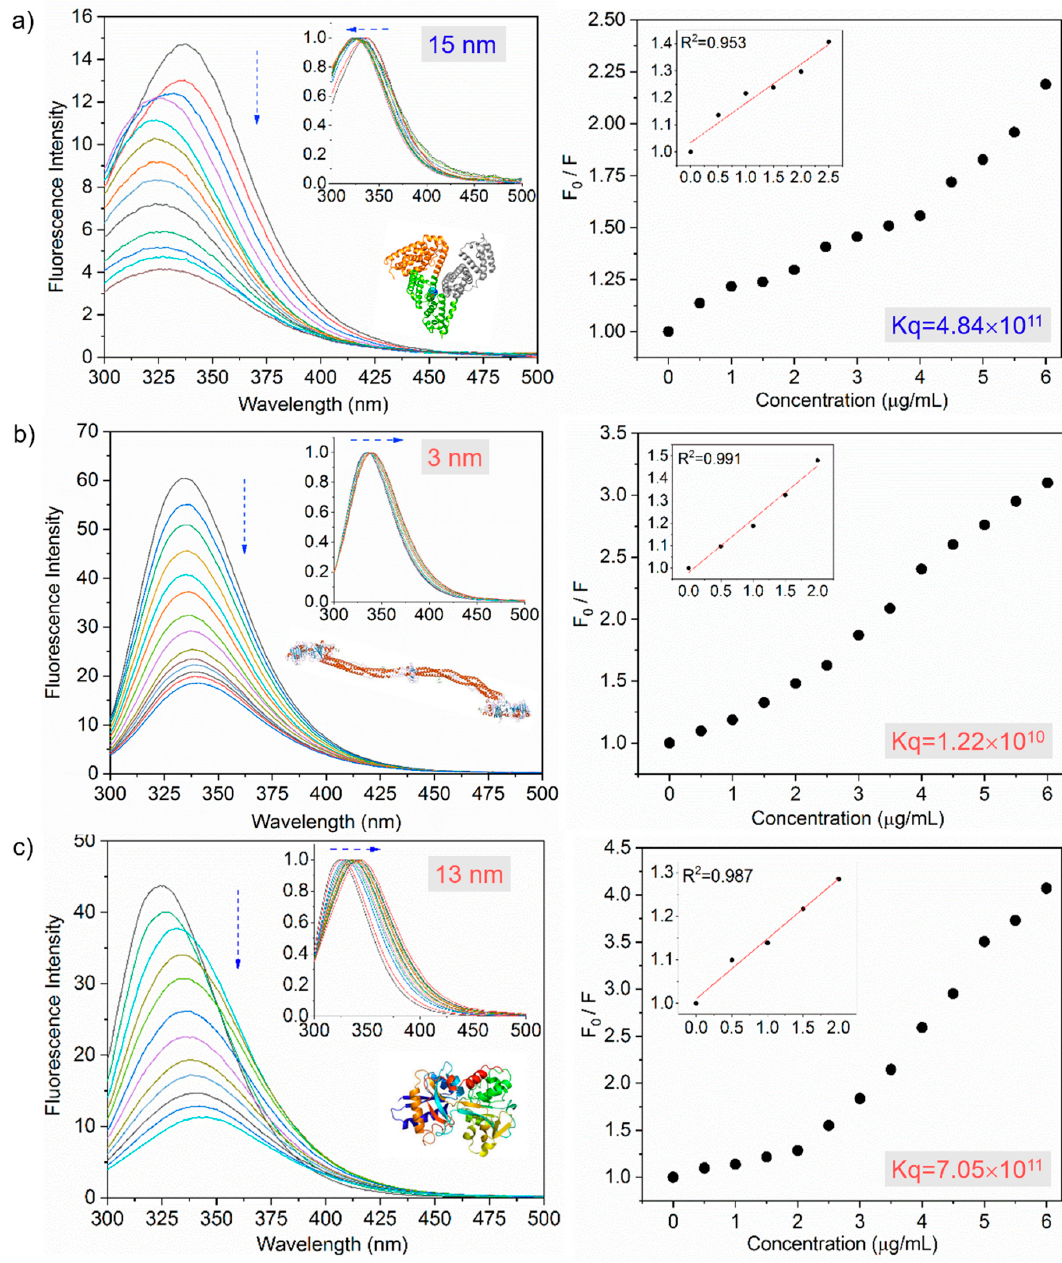
Figure 3. Fluorescence quenching (down arrow) of plasma proteins by SiQDs / F127 nanoparticles. Fluorescence emission spectra and its corresponding Stern–Volmer plots of human serum albumin ( a ), fibrinogen ( b ), and transferrin ( c ) in the absence and presence of SiQDs/F127 nanoparticles. The left side panel’s inset shows the spectral shift (horizontal arrows) of protein after interaction with the nanoparticles. The inset of the right-side panel shows the Stern–Volmer plots of proteins at lower concentrations after interaction with nanoparticles. Kq represents the quenching constant after the addition of nanoparticles. Protein crystal structures are taken from the protein data bank.